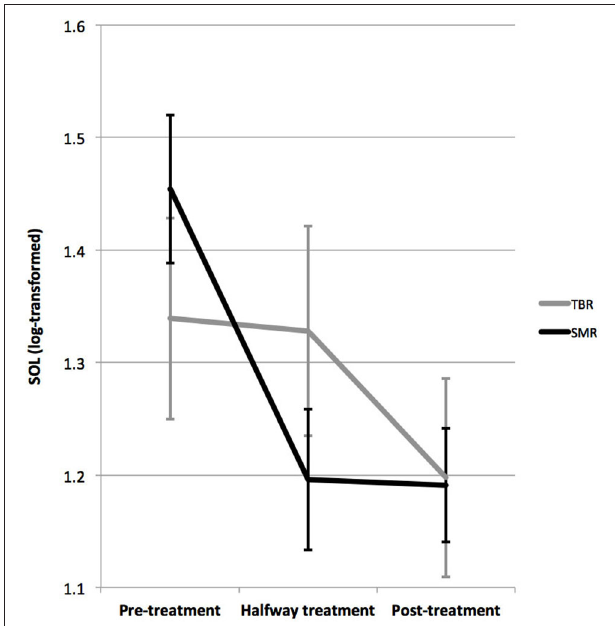
FIGURE 3 | This figure demonstrates the interaction between the SMR and TBR treated groups on SOL. The SMR treated group demonstrated a decrease in SOL from pre-treatment to post-treatment from 40 to 19 min, where this effect was most pronounced within the first half of treatment ( p < 0.001), whereas for TBR this effect was not significant ( p = 0.921) and only a significant pre-treatment to post-treatment (26 to 19 min) effect was found ( p = 0.036). The time effects were significant for both